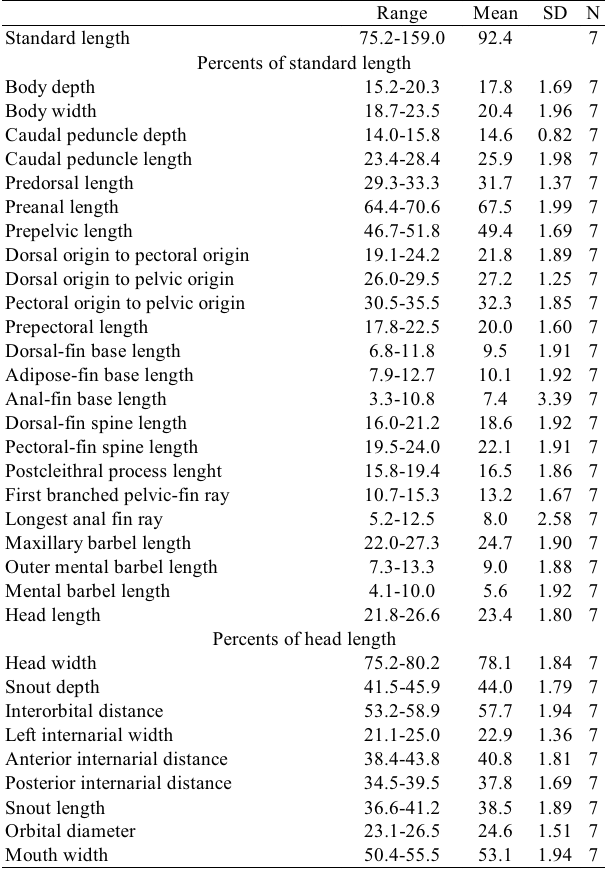
Table 2. Morphometric data for Tatia aulopygia . SD = stan- dard deviation.